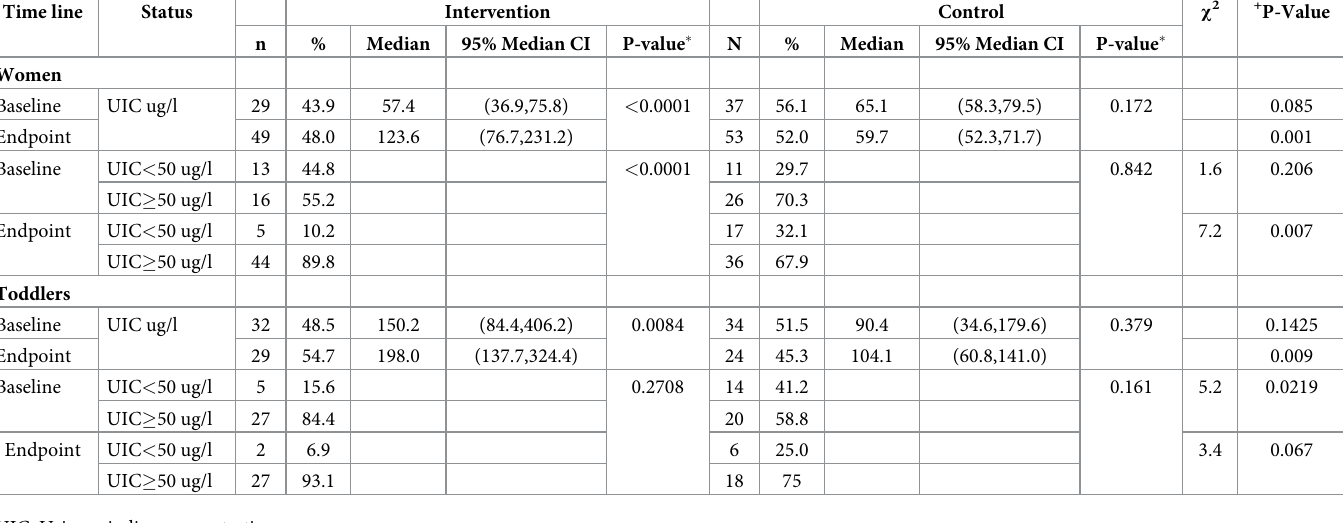
Table 3. Median UIC and distribution of UIC of childbearing age women (15–49 yrs) and their toddlers (6–23 mo) in both intervention and control groups across time. Time line